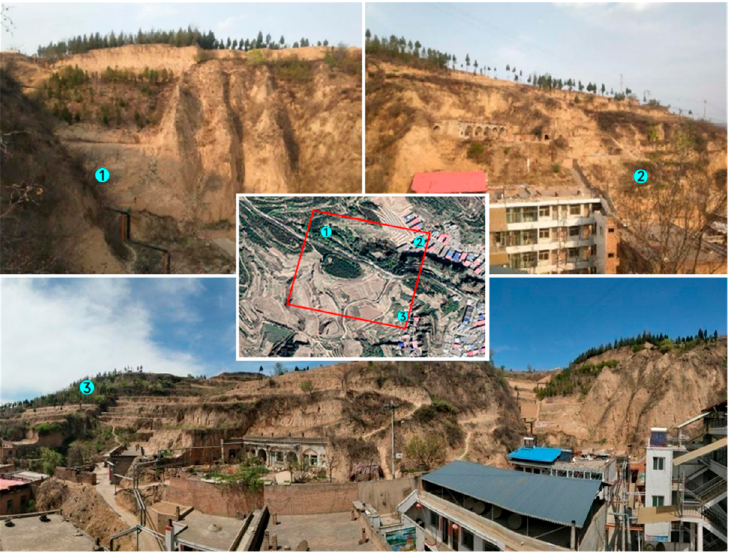
Figure 2. The complex terrain of the study area. ○ 1 Landforms on the northwest side of the study area. ○ 2 Landforms on the northeast side of the study area. ○ 3 Landforms on the southeastern side of the study area.